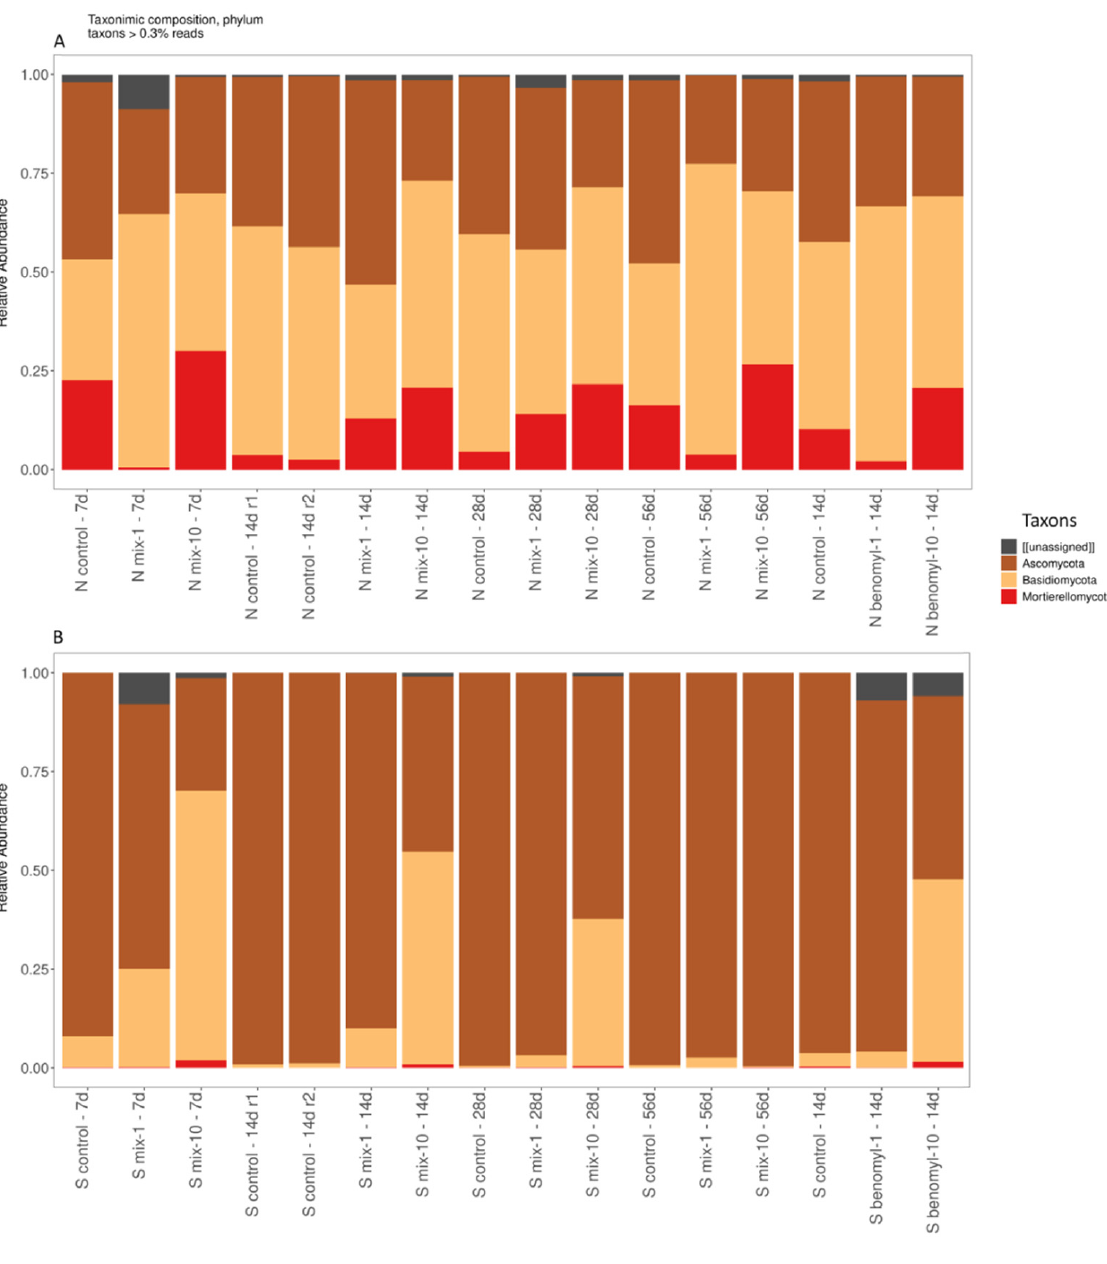
Figure 3. Fungi’s phylum in all variants of the experiments without SMM ( A ) and with SMM ( B ). In the control, the dominants were the genera Mortierella , Saitozyma , Apiotrichum , Humicola , Solicoccozyma , Fusarium , and Trichoderma (Figure